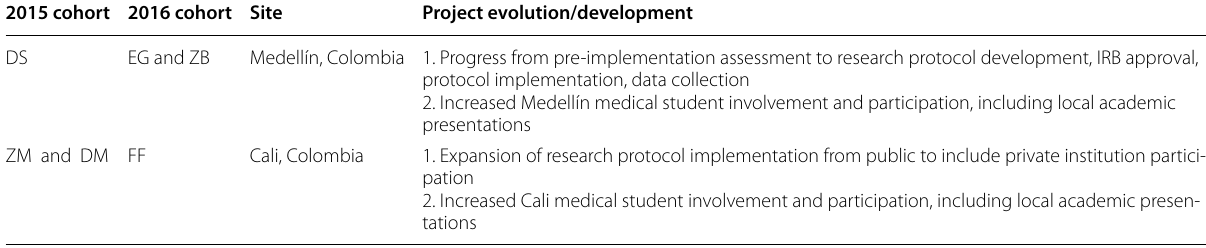
Table 4 Student peer mentorship, continuation and refinement of projects 2015 cohort 2016 cohort Site Project